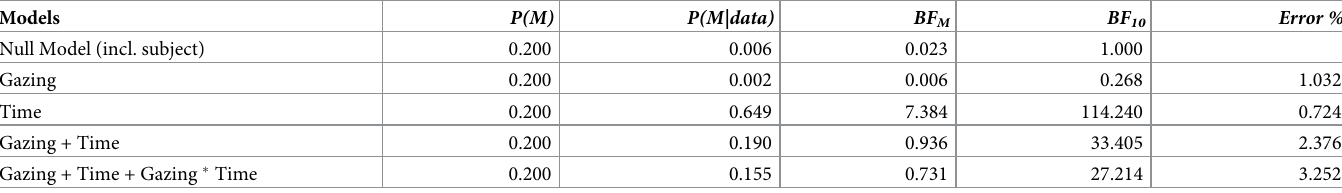
Table 2. Bayesian repeated measures ANOVA of